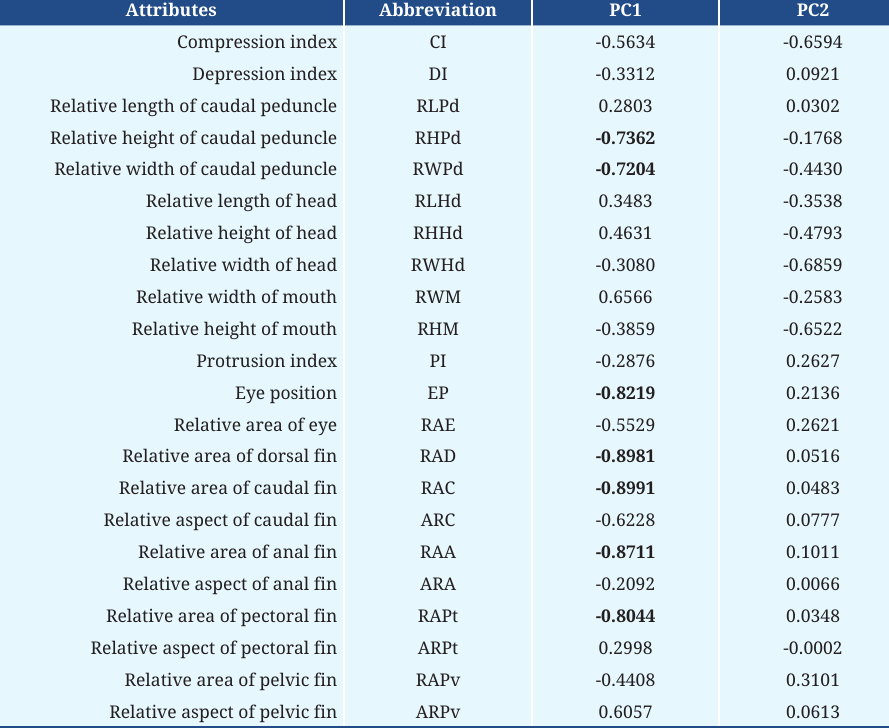
9/18 ni.bio.br | scielo.br/ni